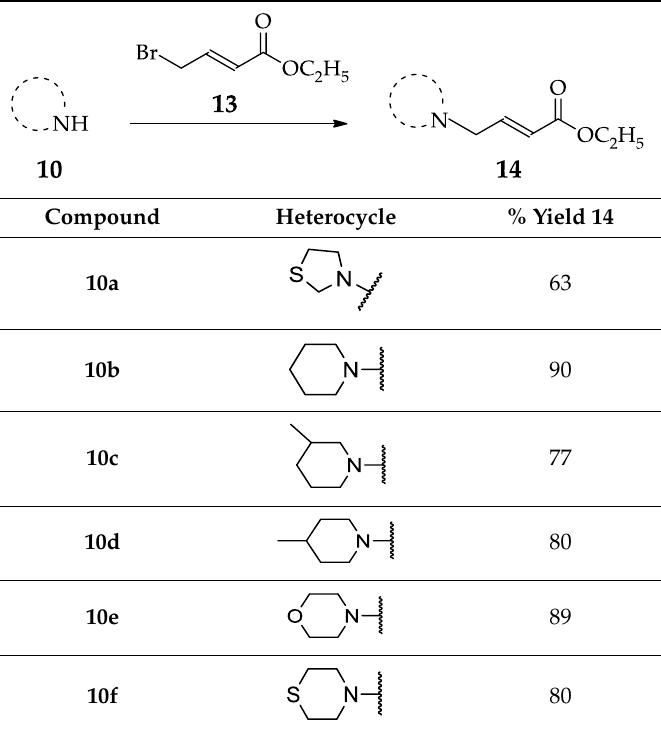
Table 2. Synthesis of conjugated esters 14 .